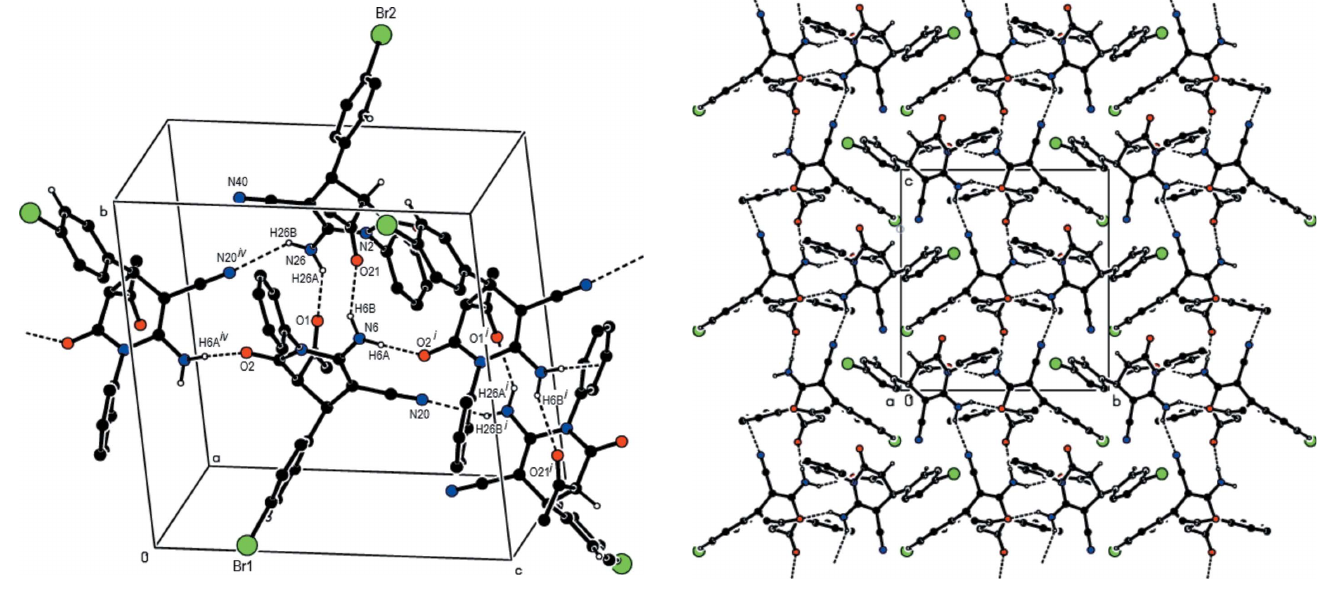
Figure 2 A general view of the N—H (cid:2)(cid:2)(cid:2) O and N—H (cid:2)(cid:2)(cid:2) N hydrogen bonds in the structure of the title compound.